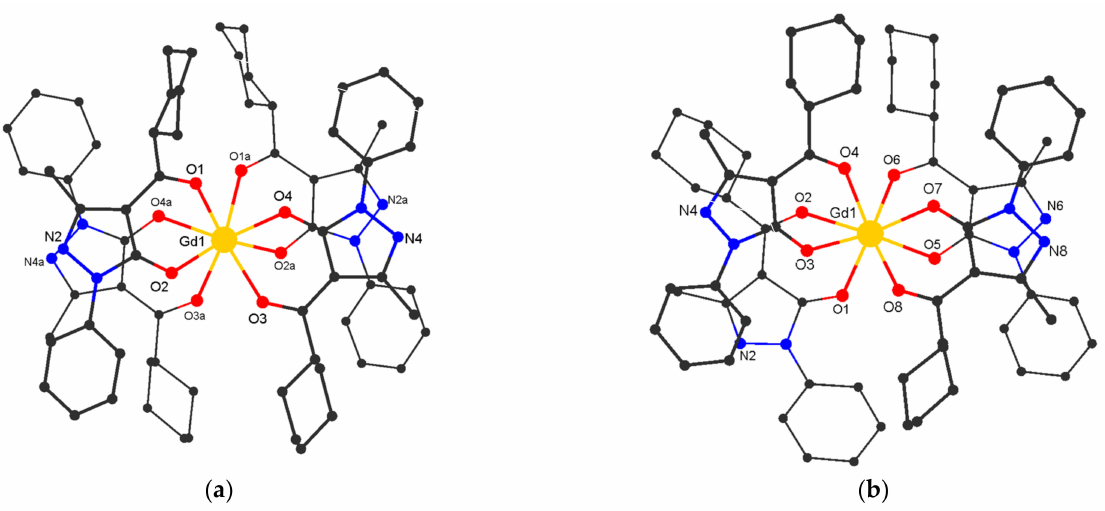
Figure 1. Structure of the anionic moiety of [Gd(Q cy ) 4 ] − in H 3 O[Gd(Q cy ) 4 ] 3 ( a ) and in [AgGd(Q cy ) 4 ] n 8 ( b ) (H atoms are